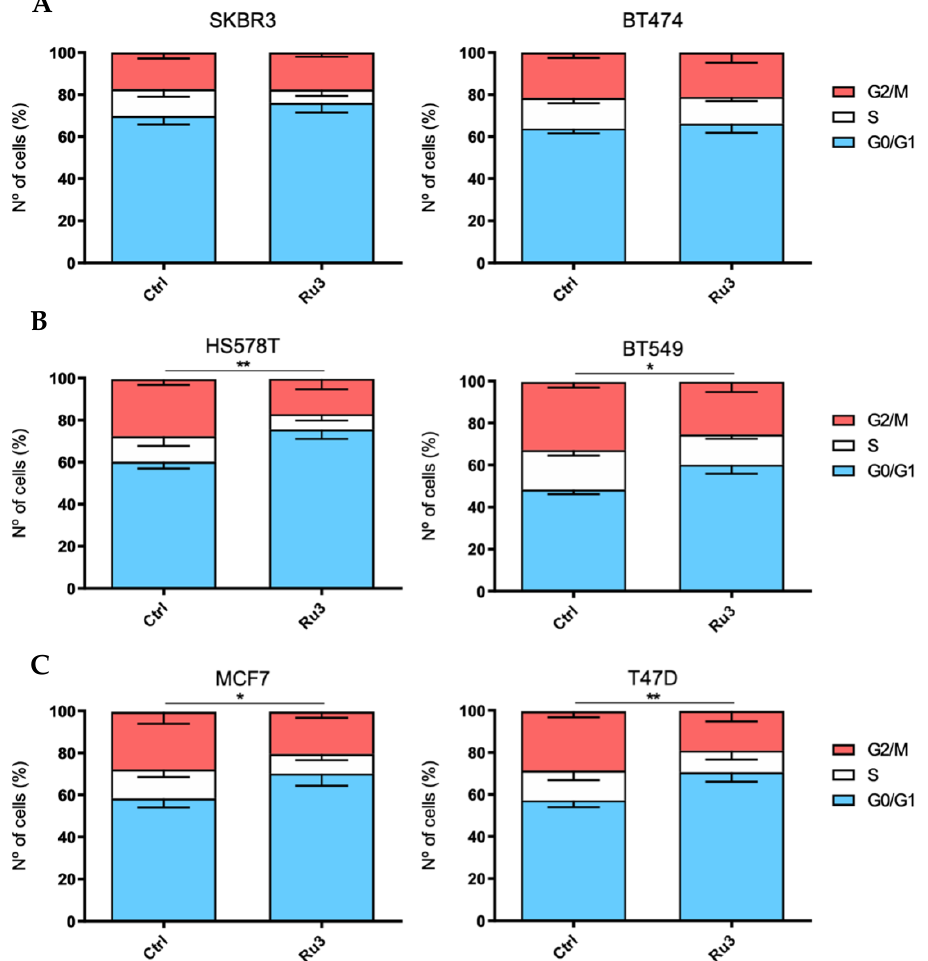
Figure 5. Evaluation of cell cycle impact exerted by Ru3 in several breast cancer cell line models. Cell cycle progression was evaluated in HER2+ ( A ), basal ( B ), and luminal ( C ) cell lines by propidium iodide staining and cytometer evaluation after 24 h of IC 50 Ru3 dose treatment for each cell line. Data are the average +/ − standard deviation (SD) of three independent experiments performed in triplicate. To determine significant statistical differences between G0/G1 phase averages, Student’s t -test was used. The values for the statistical analyses are: *, p ≤ 0.05; **, p ≤ 0.01.